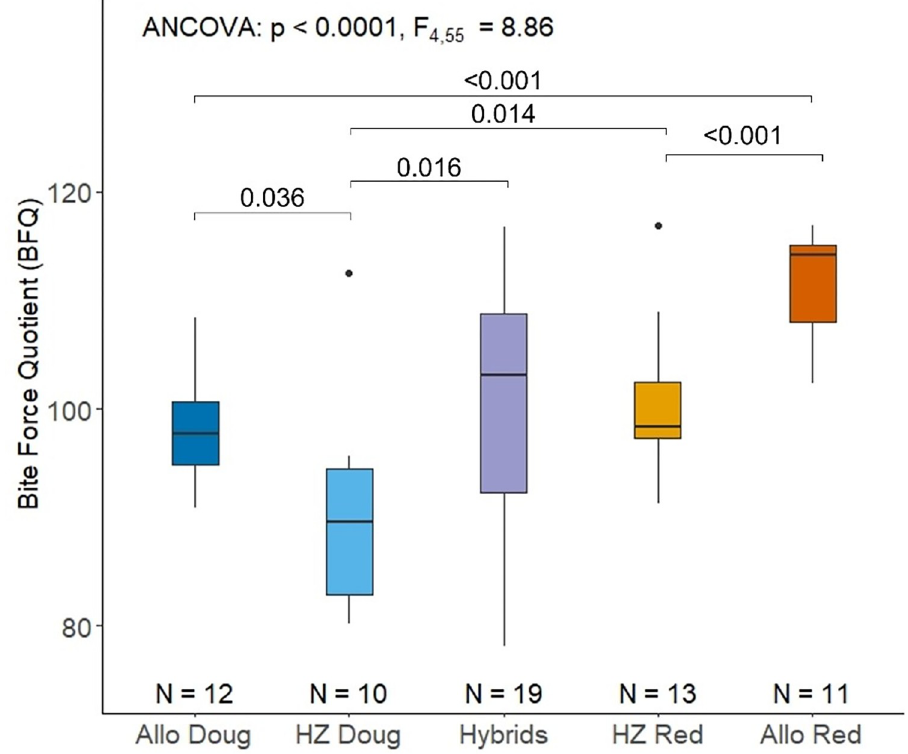
Fig 2. Boxplot showing variation in bite force quotient (BFQ) for each group of squirrels. Values on comparison bars represent significant p-values from pairwise comparisons. Outliers are indicated by black dots. Abbreviations: Allopatric Douglas squirrel, Allo Doug; Hybrid Zone Douglas squirrel, HZ Doug; Hybrid Zone red squirrel, HZ Red; and allopatric red squirrel, Allo Red. The first two axes of the PCA of all five sutures, PC1 and PC2, explain 65.95% of the variation in suture complexity (Fig 3A; PC1: 45.95%; PC2: 20.00%). PC1 is primarily driven by the com- plexity of the premaxillofrontal, maxillofrontal, and sagittal sutures with negative PC scores repre- senting greater complexity for these three sutures. PC2 is primarily determined by variation in coronal and nasofrontal sutures; with increased complexity in the nasofrontal suture associated with positive PC scores, whereas increased complexity in coronal sutures is associated with nega- tive PC scores. An ANCOVA reveals a significant difference in PC1 scores among squirrel groups (Group: p < 0.0001, F = 13.38; sex: p = 0.002, F = 10.47; size: p = 0.42, F = 0.67), but no 4,45 1,45 1,45 significant difference is present for PC2 among groups (Group p = 0.528, F = 0.81; sex: 4,45 p = 0.97, F = 0.002; size: p = 0.38, F = 0.80). Post-hoc tests reveal a significant difference in 1,45 1,45 PC1 scores between Douglas squirrels and red squirrels in allopatry (p = 0.0002), as well as in sympatry (p = 0.013), however, no significant differences in PC1 scores between allopatric Doug- las squirrel and hybrid-zone Douglas squirrels (p = 0.73) or between allopatric red squirrels and hybrid-zone red squirrels (p = 0.84). Hybrids differ significantly in PC1 scores from hybrid-zone Douglas squirrels (p = 0.0379), but not from hybrid-zone red squirrels (p = 0.386).